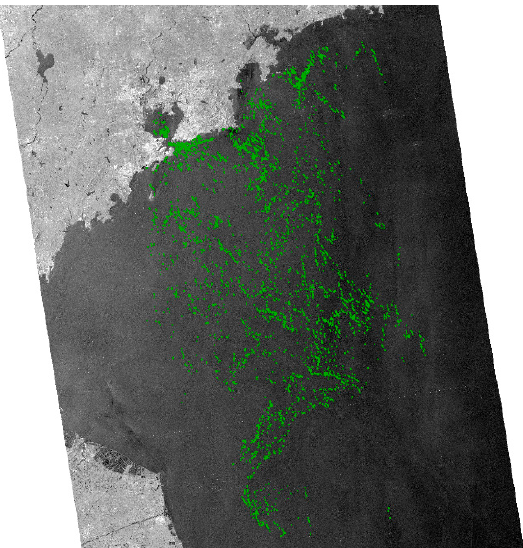
Figure 12. The extraction results of Ulva prolifera after removing the pixels of Ulva prolifera.